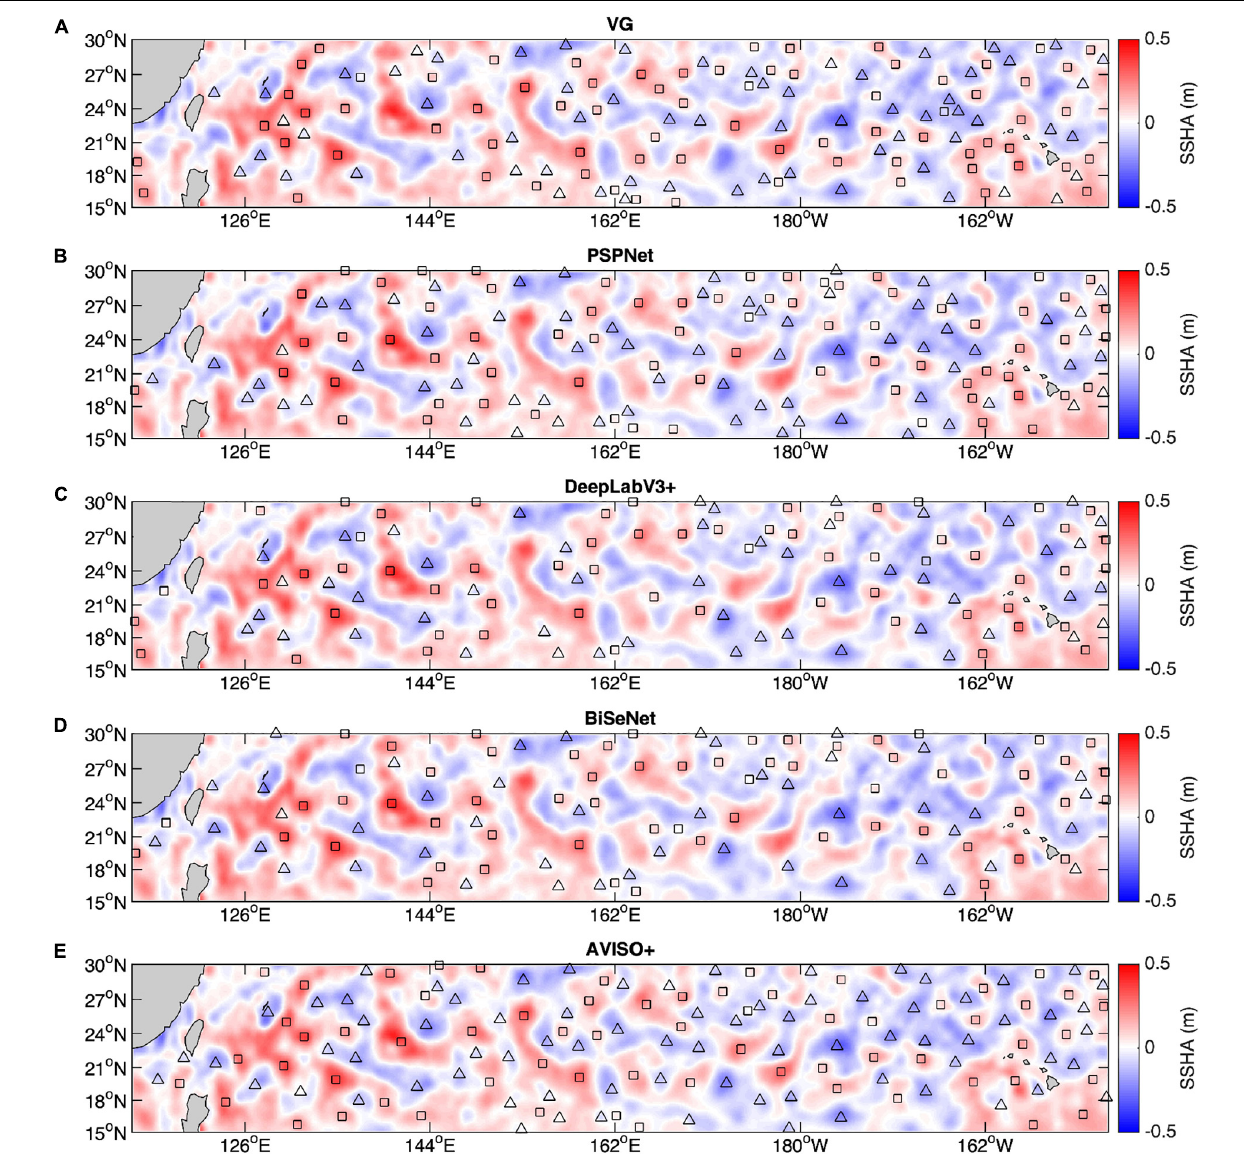
FIGURE 9 | Comparison of the oceanic eddies longer than 4 weeks from the five versions in the STCC region on June 07, 2015. (A) The VG version; (B) the PSPNet version; (C) the DeepLabV3+ version; (D) the BiSeNet version; (E) the AVISO+ version. Triangles and squares represent the center of the cyclonic and anticyclonic eddies,